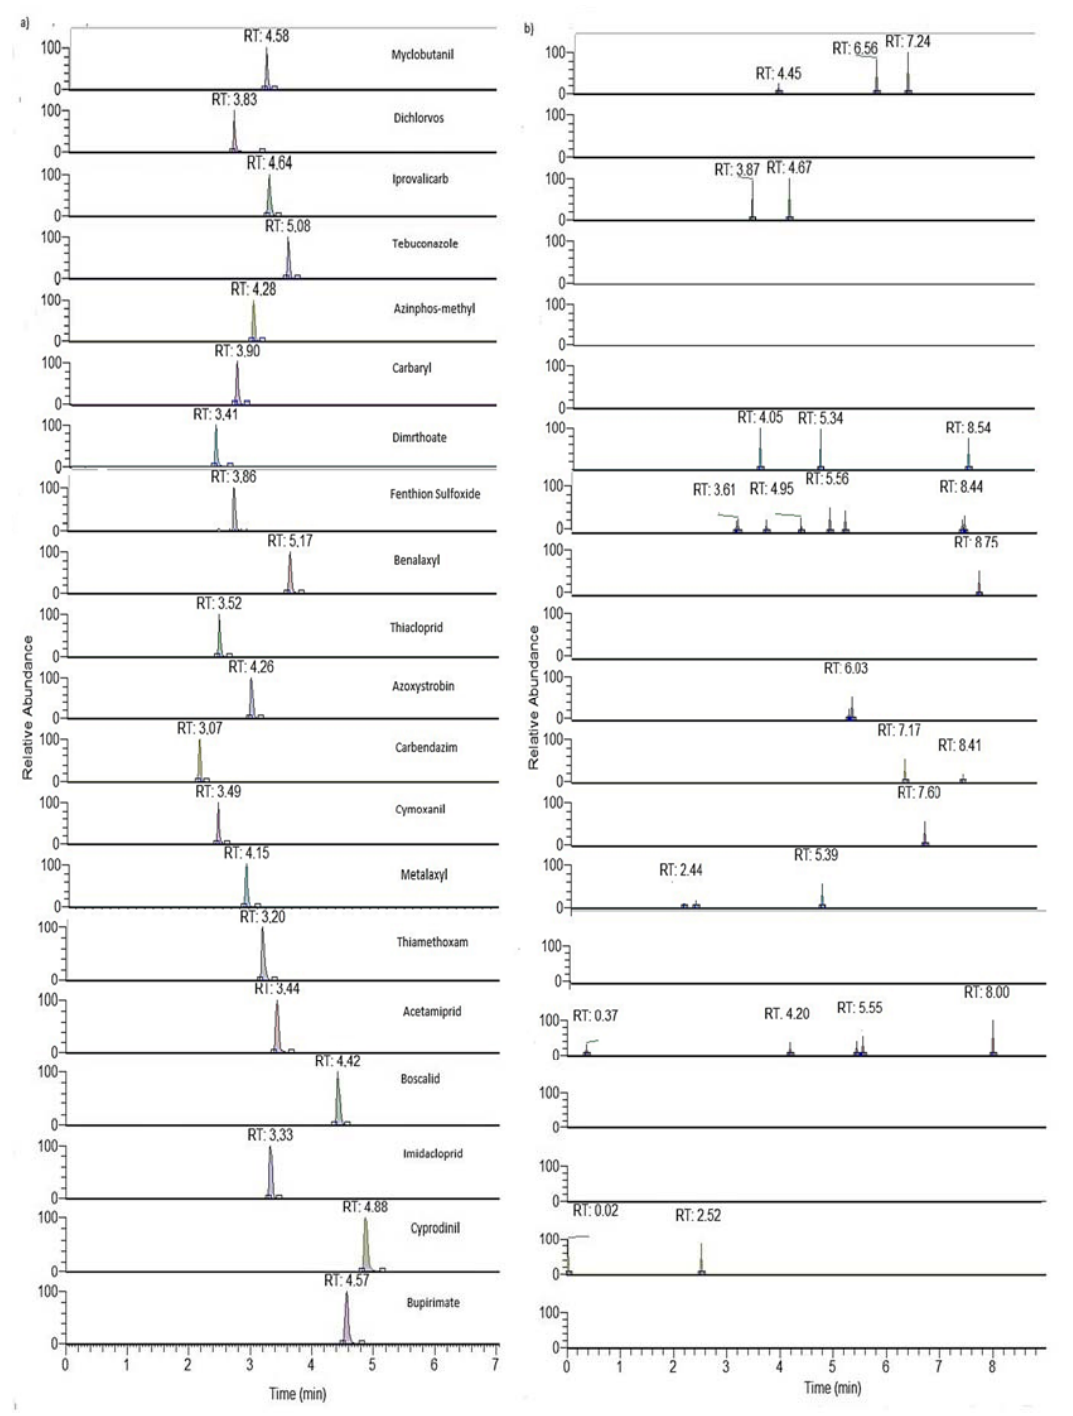
Figure 2. Extracted ion chromatogram (XIC) obtained for target compounds at ( a ) a concentration level of 500 µ g kg − 1 and ( b ) a blank sample of milk.